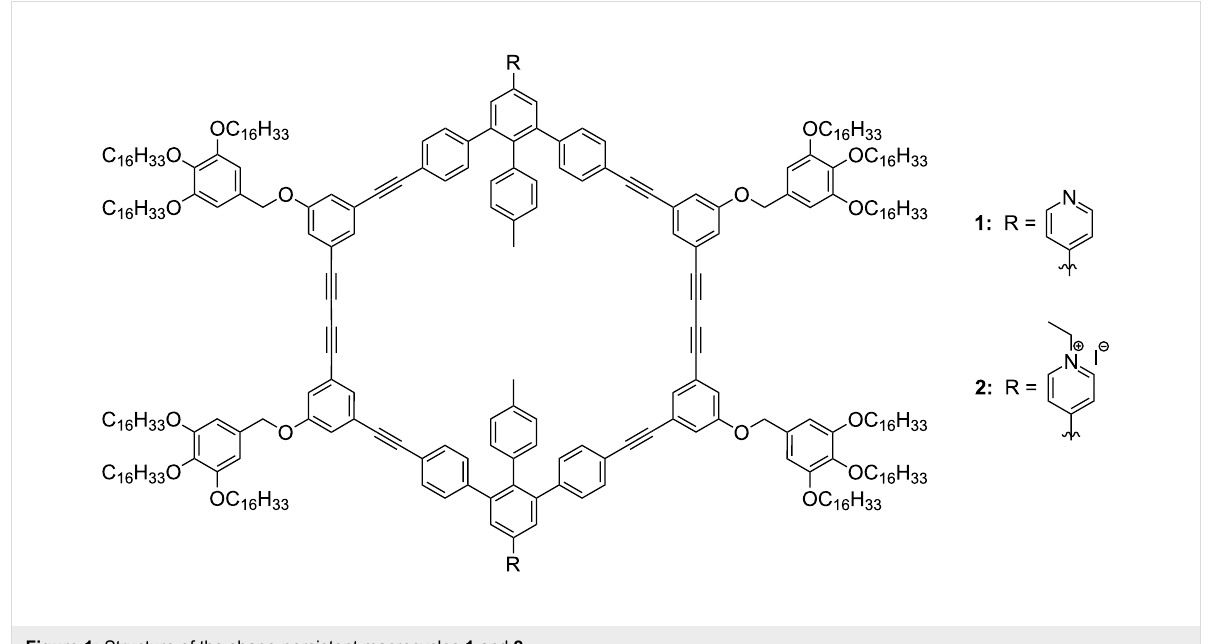
Figure 1: Structure of the shape-persistent macrocycles 1 and 2